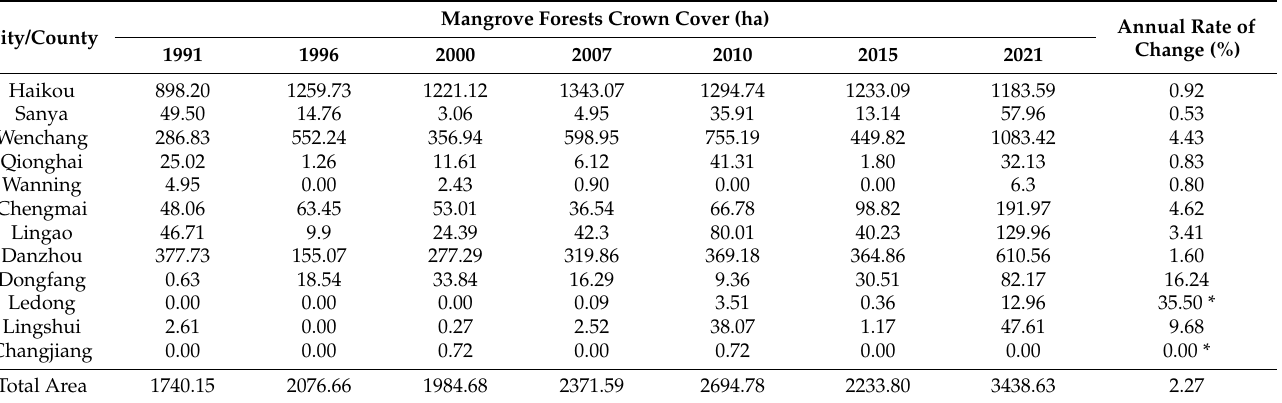
Figure 7. Trends of mangrove forest crown cover area in the Hainan Island during 1991–2021. Table 4. Mangrove forest crown surface cover area (ha) and annual rate of area change (%) in the Hainan Island and in each city/county for every year of